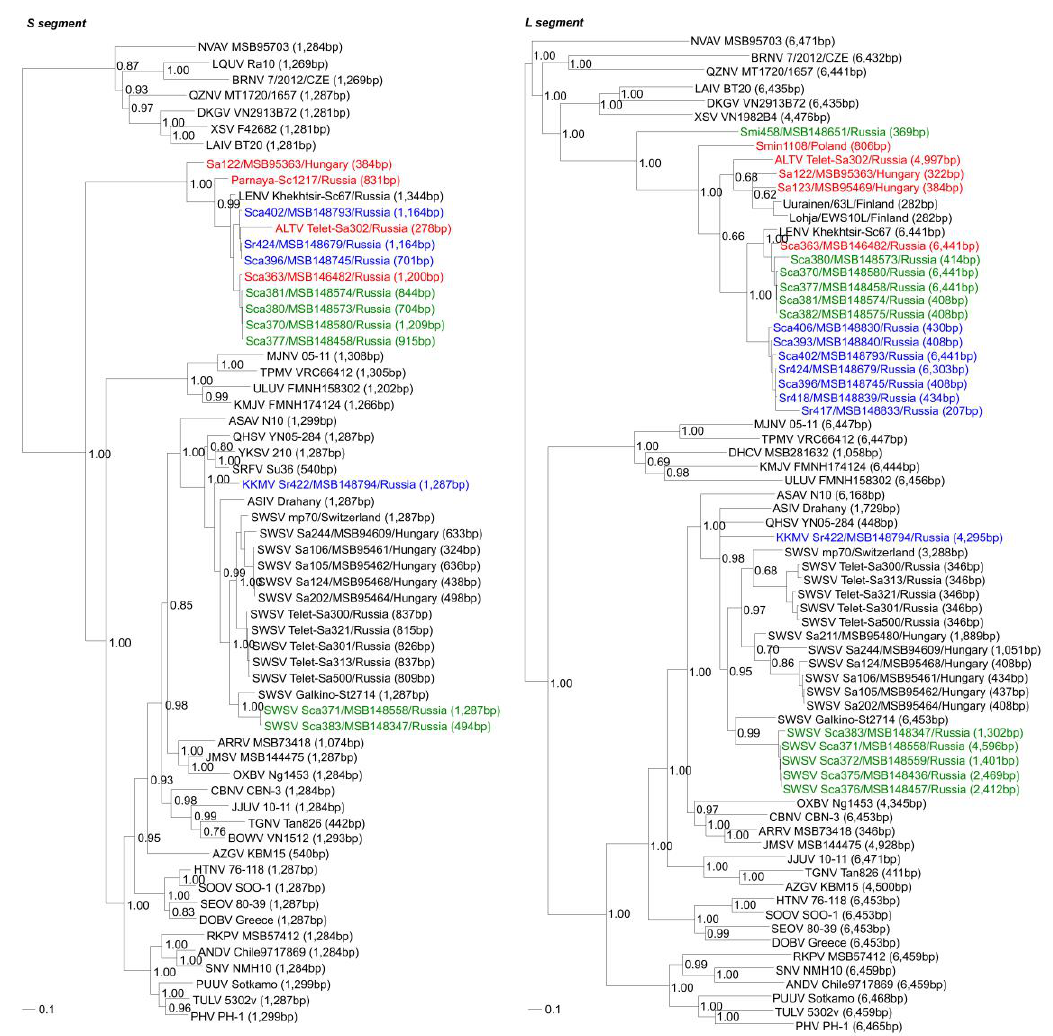
Figure 4. Phylogenetic trees, based on full-length or partial S- and L-segment sequences, generated by the Bayesian Markov chain Monte Carlo estimation method, under the general time reversible model of nucleotide evolution with gamma-distributed rate heterogeneity and invariable sites (GTR + I + Γ ), showing geographic-specific clustering of hantaviruses detected in Sorex caecutiens and Sorex roboratus captured along the Kenkeme River (blue) and Amga River (green). Altai virus (ALTV Telet-Sa302, S: KP657656; L: EU424341) and ALTV-related hantaviruses formed a monophyletic group that shared a common ancestry with mobatviruses, including L á ib¯ın virus (LAIV) strains BT20 (S: KM102247; L: